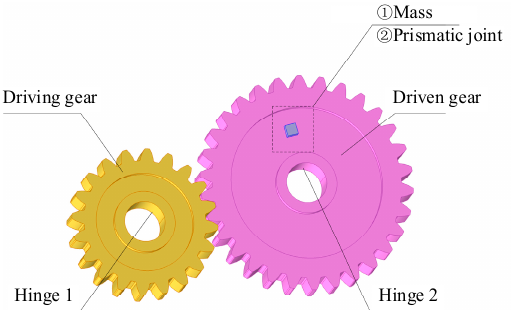
Figure 9. Virtual prototype model of the gear system and vibration absorber.